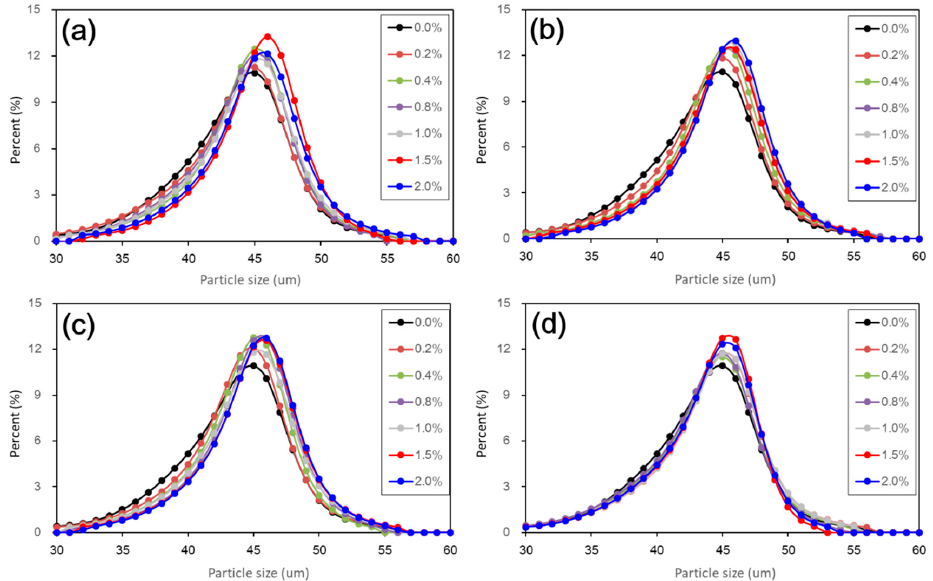
Figure 7. Effect of nano-SiO 2 content and curing duration on frequent distribution curves of particle size of treated loess. ( a ) 7 days; ( b ) 14 days; ( c ) 28 days; and ( d ) 60 days.